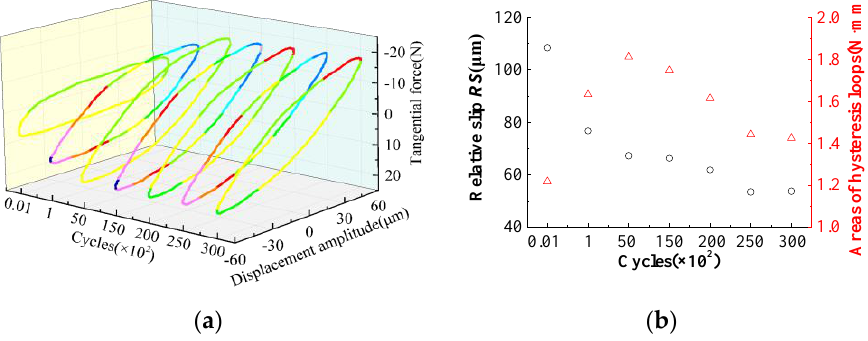
Figure 4. Fitting of wear depth profiles of cyclic loaded wires in cases of distinct environmental media.